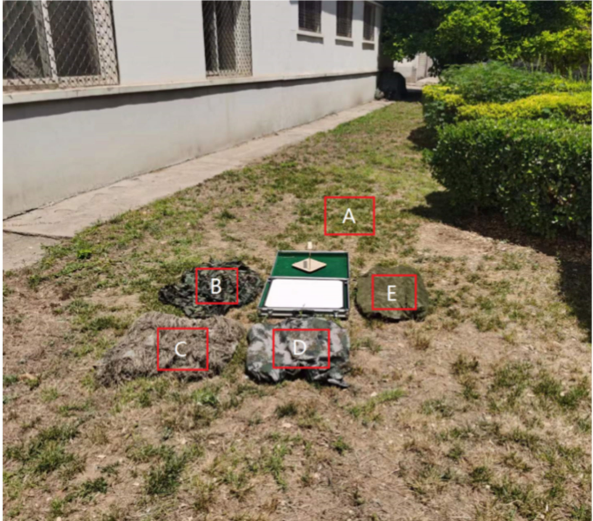
Figure 2. Relative position of the targets in Experiment 1.